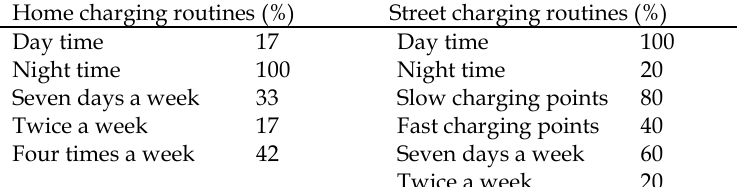
Table 10 Private users’ charging routines (percentage of participants)